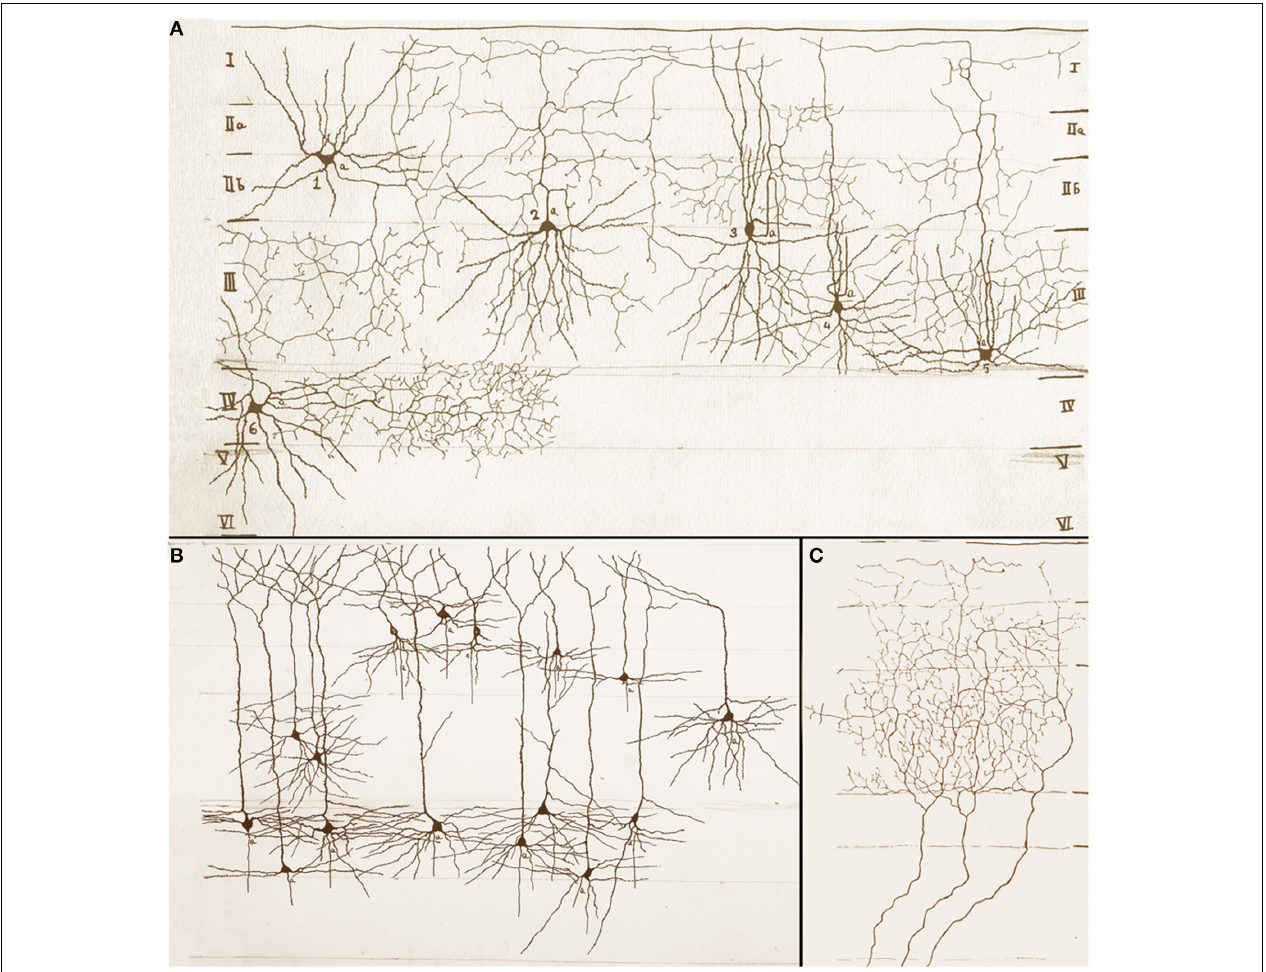
FIGURE 3 | Assorted drawings of the mouse cerebral cortex by Rafael Lorente de Nó. (A) Examples of short-axon neurons that include ascending (cells 2, 4 and 5), descending (cell 1), and horizontal (cells 3 and 6) axons. Roman numbers at either side of the drawing